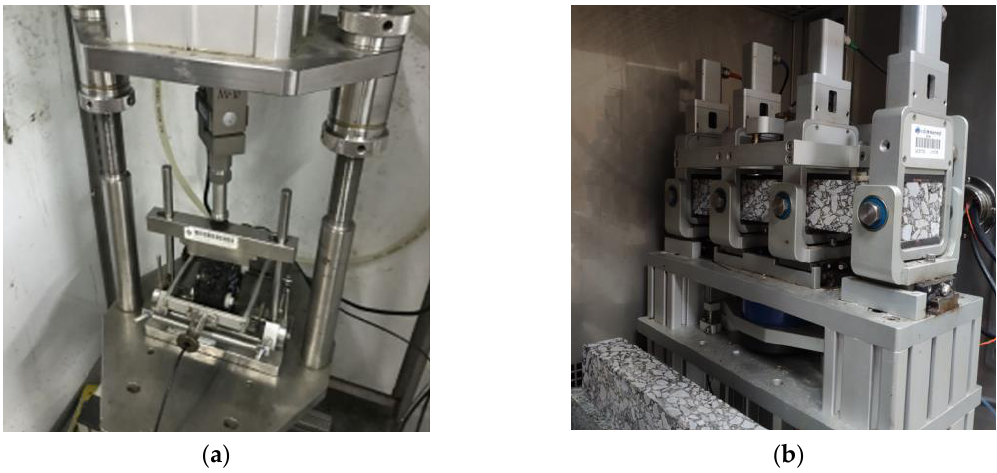
Figure 2. Fatigue characterizing tests: ( a ) indirect tensile fatigue test (ITFT) test for mixtures; ( b ) 4PB test for mixtures.